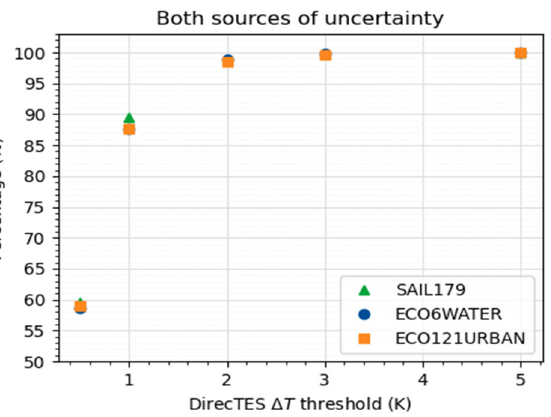
Figure 11. Percentage of pixels for which a temperature is retrieved by DirecTES with both uncer- tainty sources.